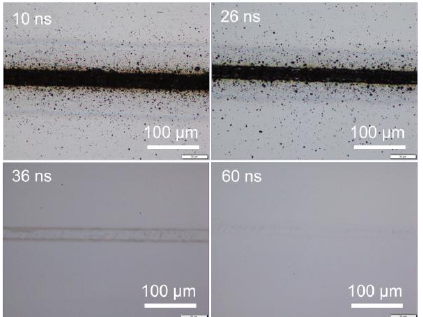
Figure 1. Optical images of irradiated silicon surfaces with 0.04 mJ in pulse energy (5.12 J/cm 2 ) at a scanning speed of 50 mm/s.